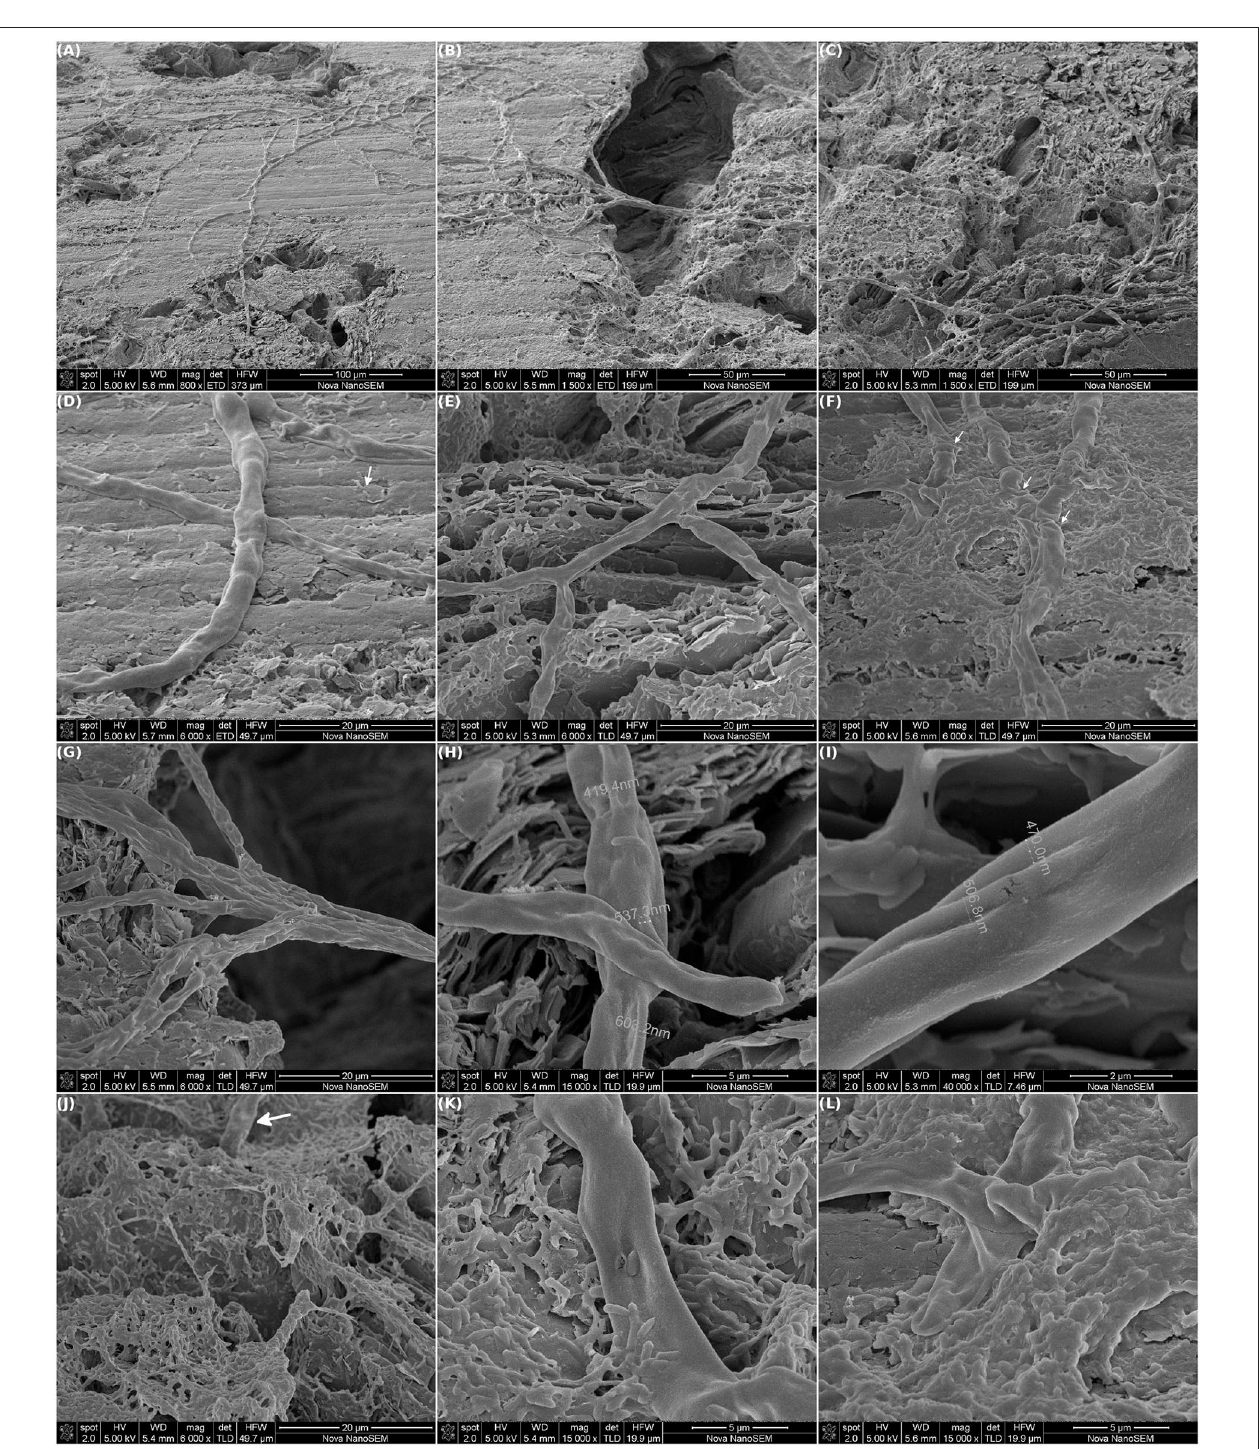
FIGURE 8 | Scanning electron microscopy of one of the two working electrodes of a MEC inoculated with the selected community. The WEs (graphite) were polarized at +480 mV vs. Ag/AgCl. The MEC was operated at 30 ◦ C in anaerobiosis. At approx. 144 h of operation, one WE was removed and prepared for SEM. (A–C) Intertwined millimeter long cables of bacteria running along the WE surface. (D–F) Differences in the biofilm structure were observed over the electrode: zones of high density of cables and low density of isolated cells ( D , white arrow), and zones with low density of cables and higher density of aggregated cells (E) and biofilm matrix ( F , white arrows highlight some wrinkles in the cables). (G–I) The cables were composed of many single cables. (J–L) A non-cable type biofilm seemed to be growing over the cables.